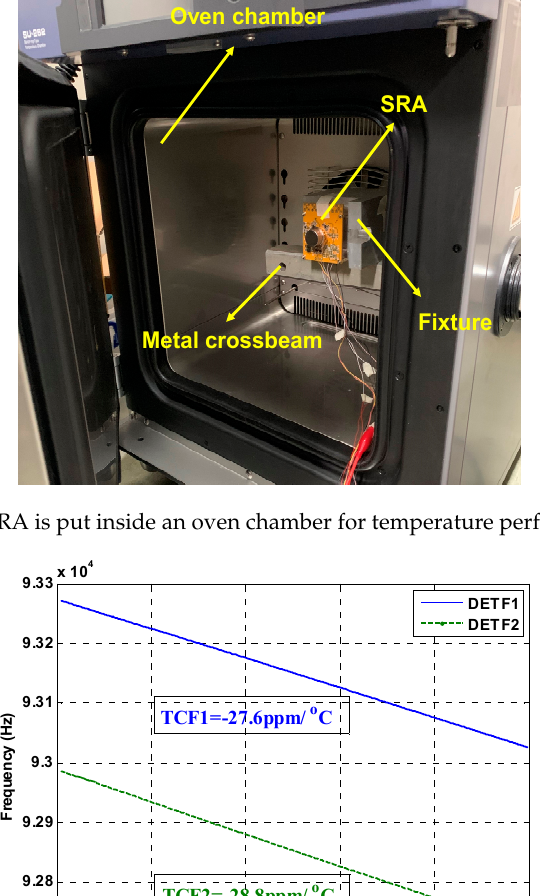
Figure 13. The resonant frequencies of the two DETFs vary with the temperature.